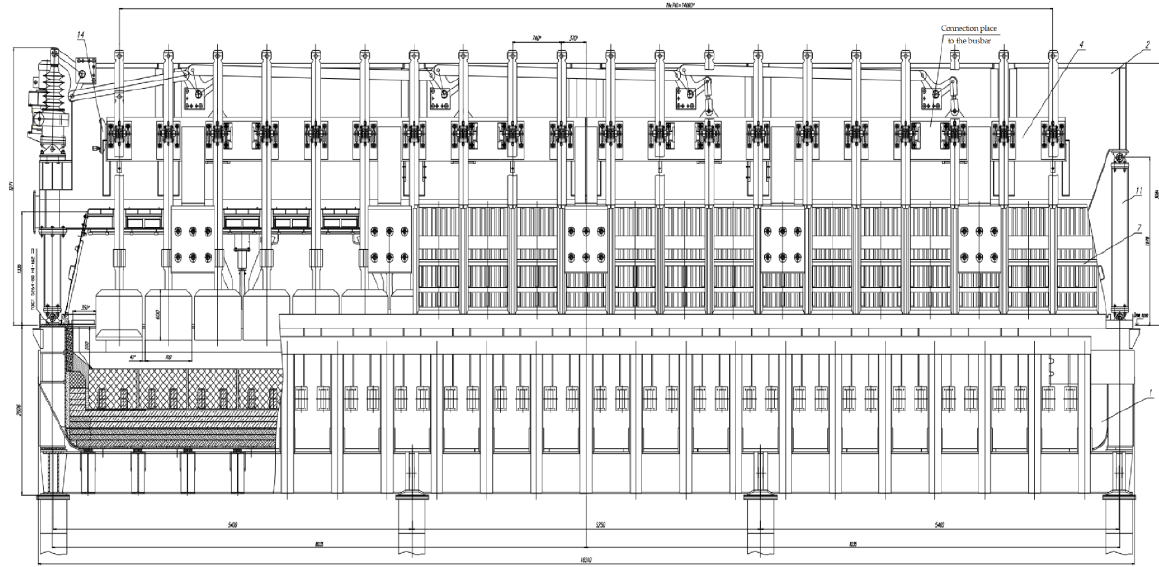
Figure 4. Longitudinal section of the OA-300M electrolysis cell [31].